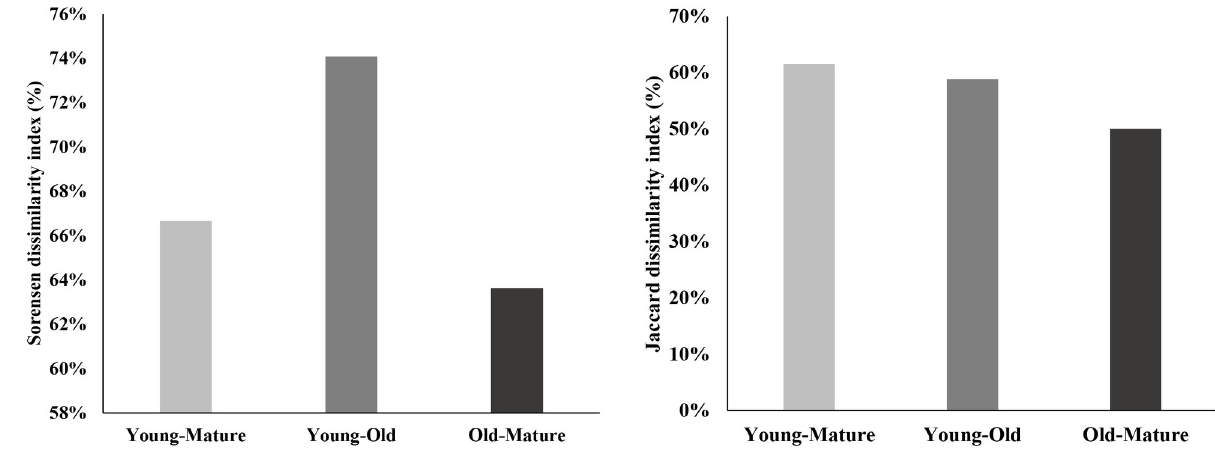
Fig 4. Species dissimilarity between cocoa plots according to age groups.